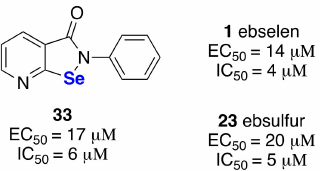
Figure 7. Structure of compound 32 and pharmacological data for compounds 1 , 23 and 33